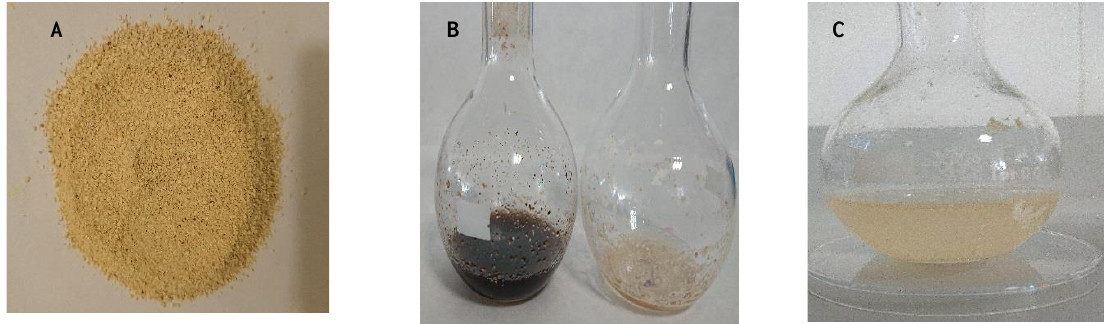
Fig. 1 Processing of eggshell